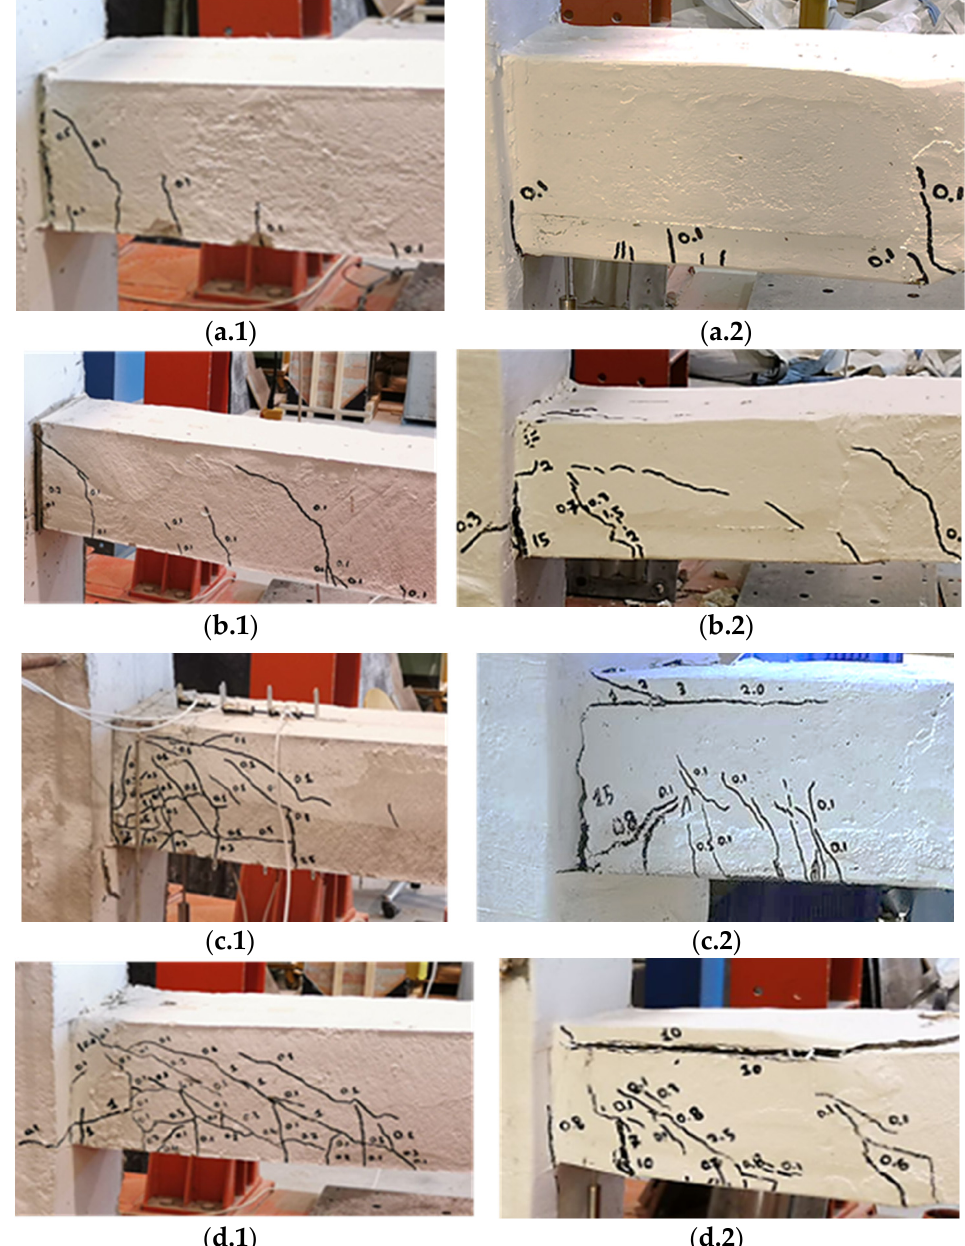
Figure 11. Failure modes of specimens: ( a.1 ) M1.6 Φ 10NL vs. ( a.2 ) RM1.6 Φ 10NL; ( b.1 ) M3.1 Φ 14NL vs. ( b.2 ) RM3.1 Φ 14NL; ( c.1 ) M1.6 Φ 10L35 vs. ( c.2 ) RM1.6 Φ 10L35; ( d.1 ) M3.1 Φ 14L35 vs. ( d.2 ) RM3.1 Φ 14L35.